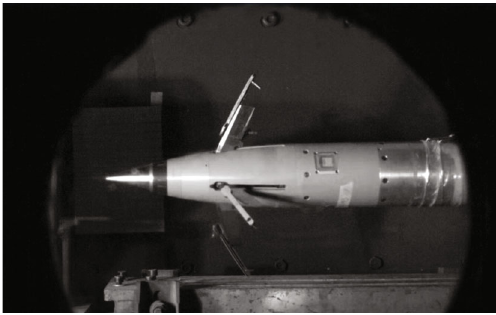
Figure 1: The state when the rudder is just opened.